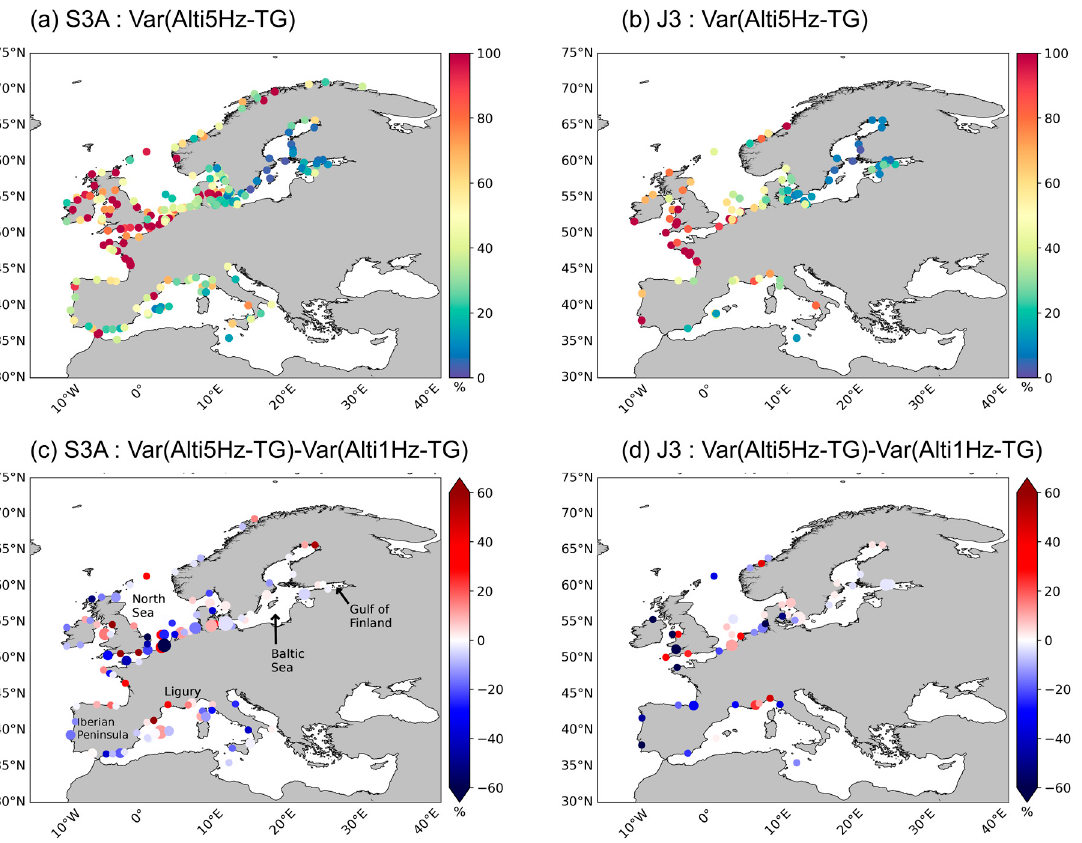
Figure 8. Top: Variance in the differences between S3A ( a ) and J3 ( b ) altimeter measurements and TG SLA signal when the 5Hz altimeter product is used. Bottom: Difference between the results obtained with the DUACS 1Hz product for S3A ( c ) and J3 ( d ). Large dots indicate clusters of neighboring TGs that have been weighted for the computation of global mean statistics. Negative values mean that the SLA differences between altimetry and TGs are lower for the 5Hz products (unit: % of the variance in the TG signal).